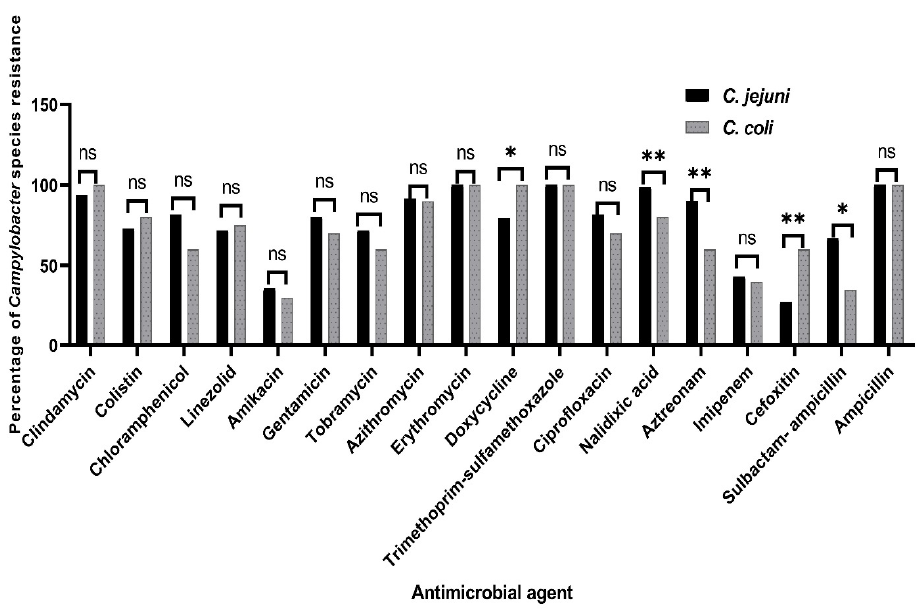
Figure 1. Prevalence of Campylobacter jejuni and C. coli resistance against 18 antimicrobial agents. ns: non-significant, * p < 0.05, ** p < 0.01. non-significant, * p < 0.05, ** p < 0.01.